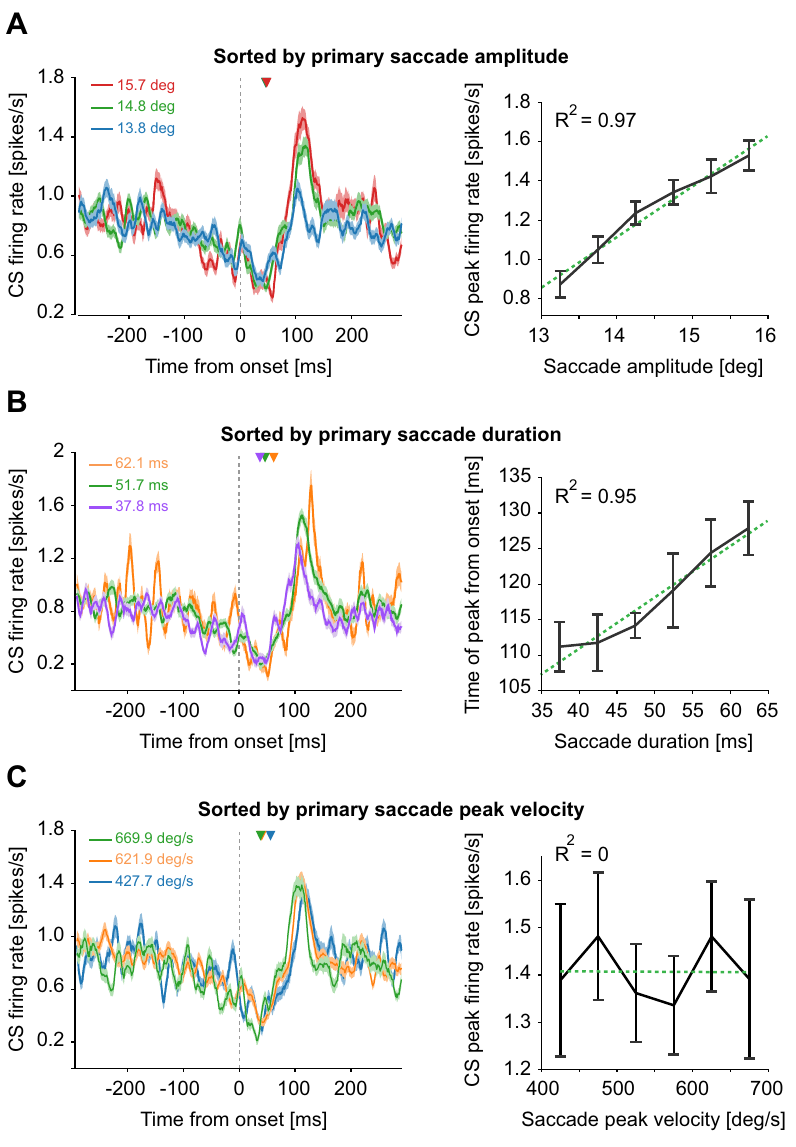
Fig 2. CSs encode primary saccade amplitude and duration but not peak velocity during the “early postsaccadic period” . (A) CS population response (mean ± SEM) aligned to the onset of all primary saccades (PD ps and PD ps + 180˚ combined) sorted by different amplitudes (left panel). The relationship between saccade amplitudes and peak firing rate of CSs is demonstrated with the help of a linear regression (right panel). (B) Population response (mean ± SEM) to saccades sorted by durations (left). The relationship between the timing of peak response (bootstrapped mean ± confidence intervals) and saccade duration is shown on the right. (C) Population response (mean ± SEM) to saccades with different velocities (left) and the corresponding regression plot (right). Green dotted lines represent the linear regression fits. The average saccade offset of each amplitude, duration, and peak velocity bin is denoted by inverted triangles in left panels. Note that the average onset of the upcoming corrective saccades occurred 349.2 ms after saccade onset. Underlying data available from the Dryad Digital Repository: [https://doi.org/10.5061/dryad. d51c5b03m]. CS, complex spike. demonstrates the CS responses of an exemplary PC neuron (same PC as in Fig 1D) around the time of corrective saccades made during a single behavioral session. Trials, aligned with cor- rective saccade onset, were sorted according to the direction of the corrective saccade (left